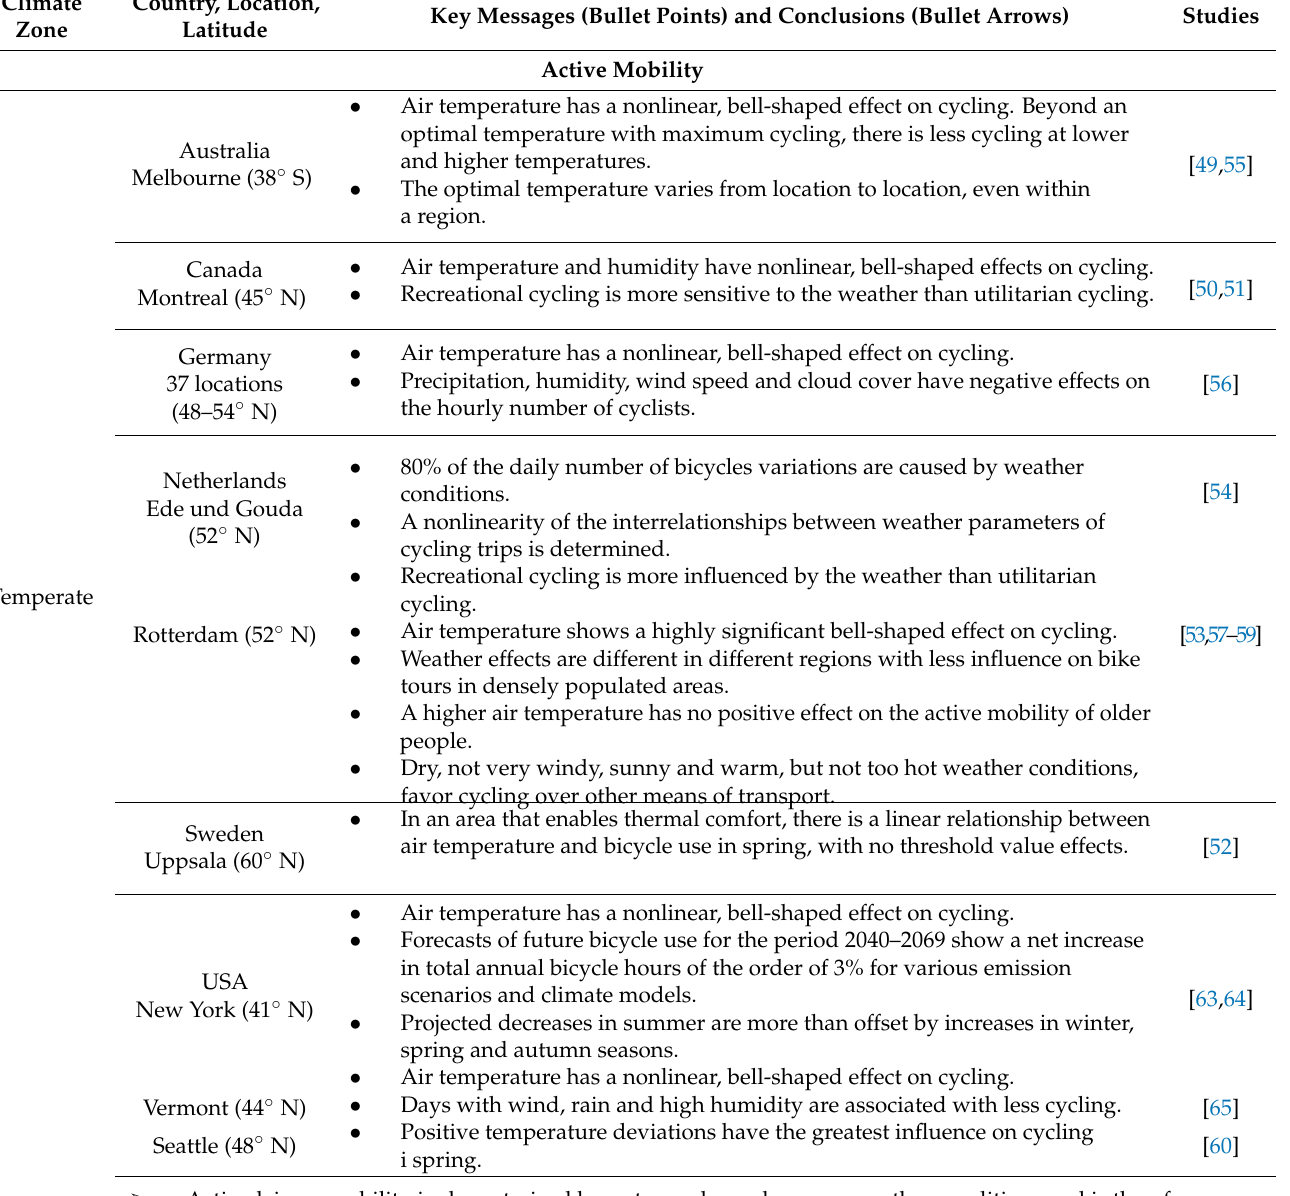
Table 4. Cont . Key Messages (Bullet Points) and Conclusions (Bullet Arrows)